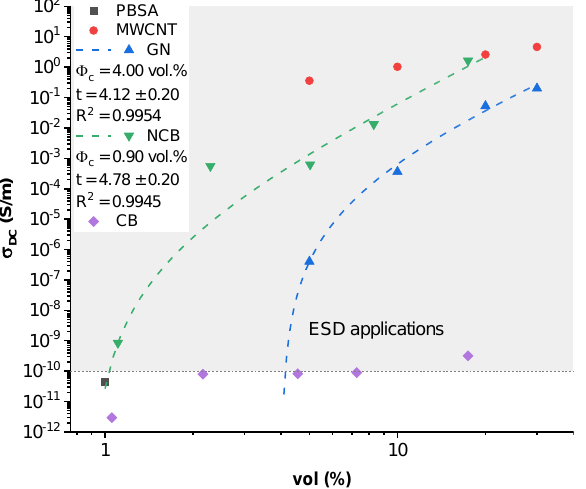
Figure 2. DC conductivity with log − log fit of PBSA/carbon nanoparticle composites.